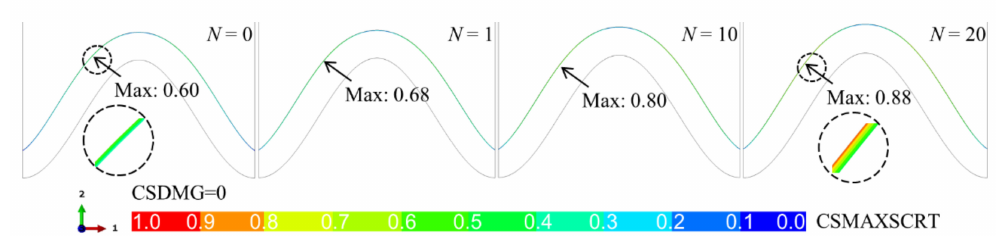
Figure 9. Evolution of damage initiation variable (CSMAXSCRT) in the ceramic layer near the interface without a bulge (at room temperature).